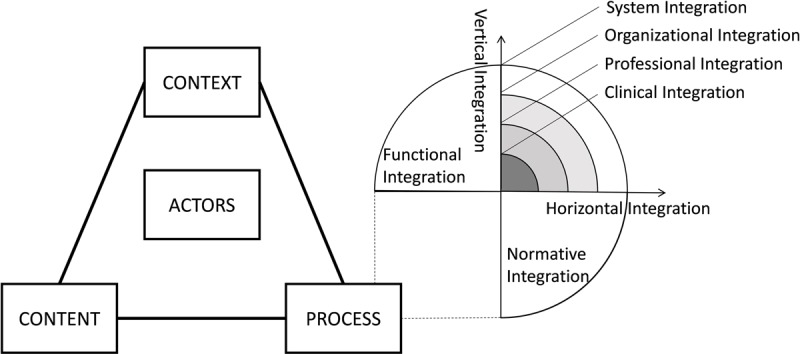
Conceptual framework.Note: The conceptual framework was built based on the policy triangle framework [3233] and the framework of if integrated care [3435].